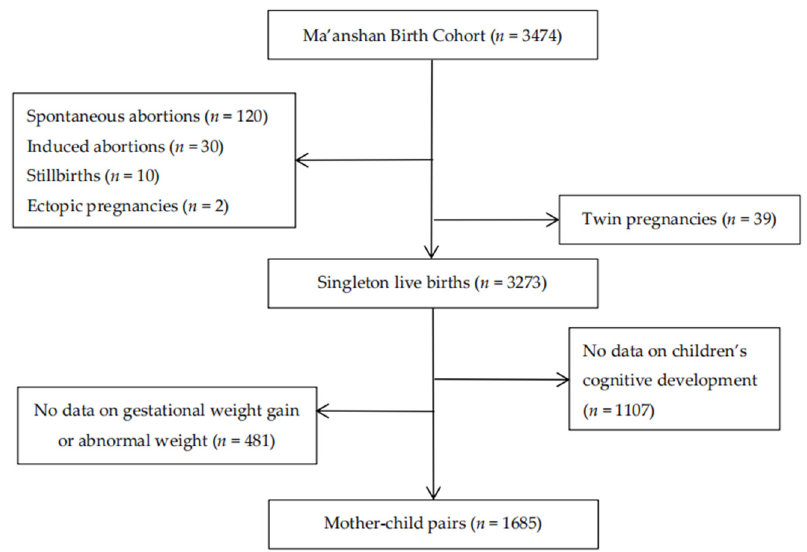
Figure 1. Flow chart of recruited participants.